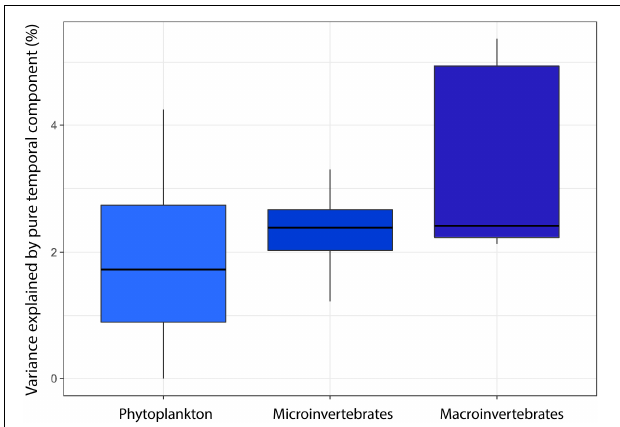
FIGURE 4 | Percentage of variance explained by pure temporal effects for three groups with different generation times: Phytoplankton (Cyanobacteria, Chlorophyceae, mixotrophic phytoplankton, and Diatomea), Microinvertebrates (Rotifera, Branchiopoda, Copepoda, and Ostracoda) and Macroinvertebrates (Mollusca, Paleoptera, Heteroptera, Coleoptera, and Diptera).